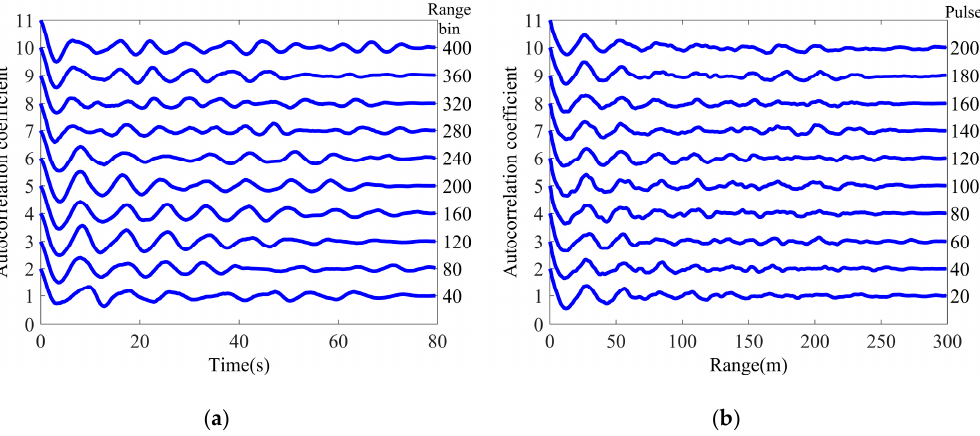
Figure 9. Correlation coe ffi cients in a single range bin and pulse of texture: ( a ) Temporal correlation; ( b ) Spatial correlation.